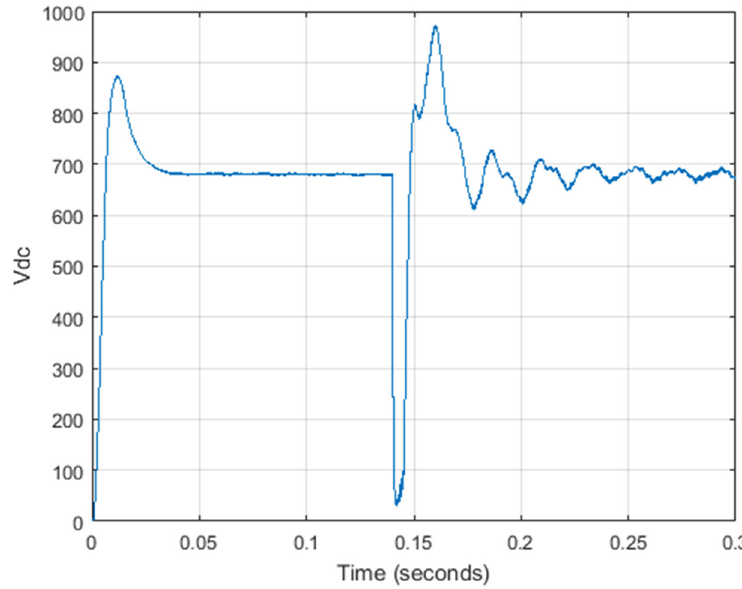
Figure 19. DC voltage in scenario 3.